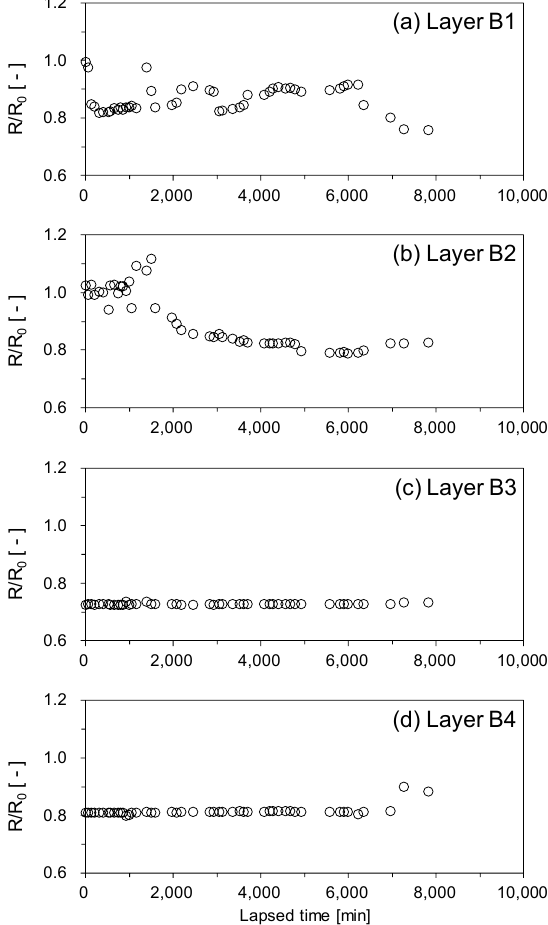
Figure 11. Normalized electrical resistance R / R 0 of the unconsolidated sediment sample during depressurization. ( a ) layer B1, ( b ) layer B2, ( c ) layer B3, ( d ) layer B4.